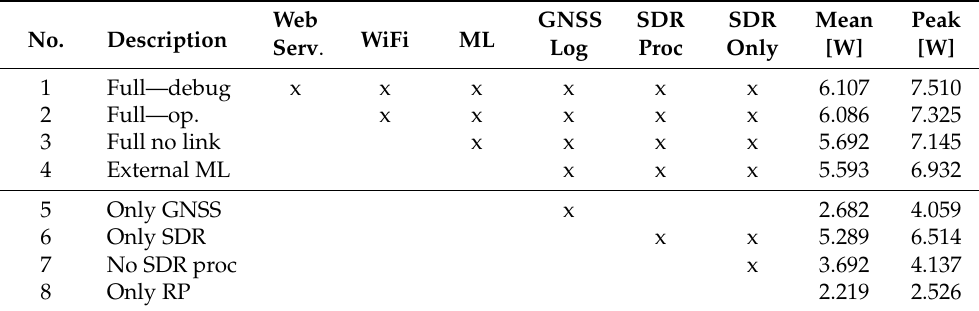
Table 1. Power consumption test configurations and